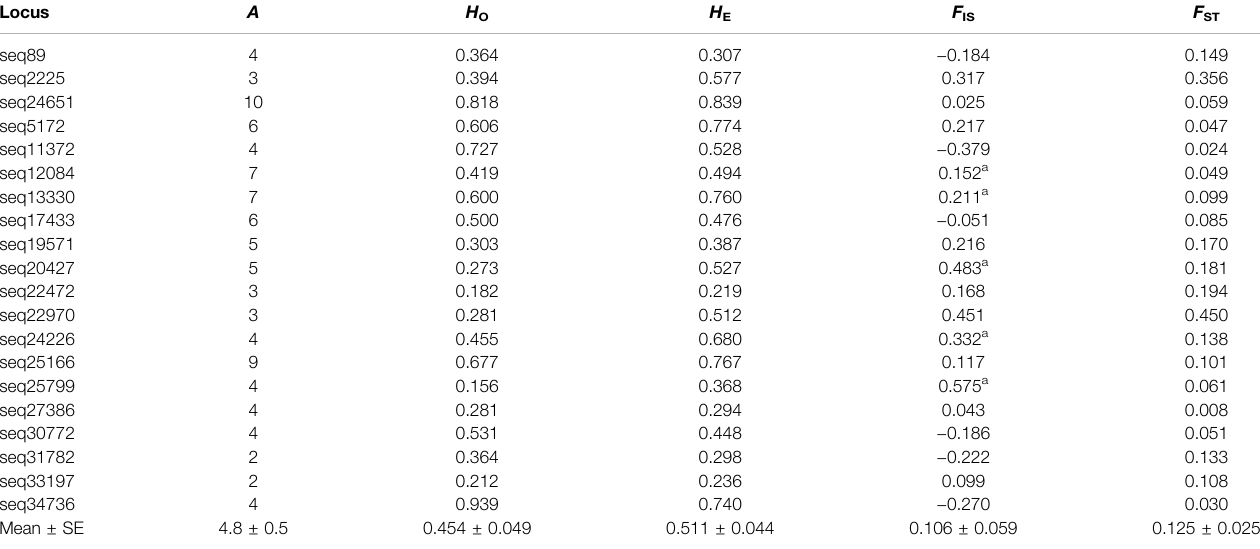
TABLE 3 | Genetic variation of 20 microsatellite markers used in this study in the population of Xanthocyparis vietnamensis in Guangxi, China. Locus A H O H E F IS seq89